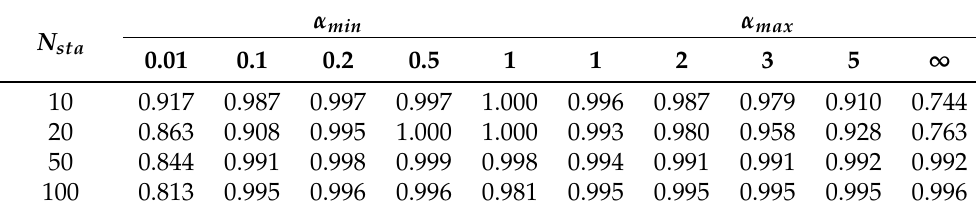
Table 4. Fairness index values for various values of α min s, α max s, and N sta